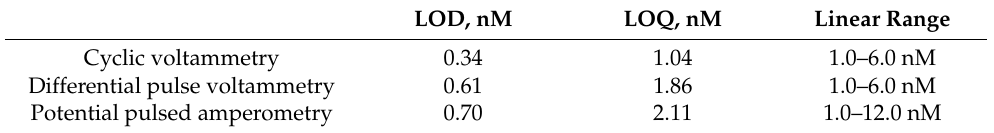
Table 1. Comparison of the LOD and LOQ values obtained by the three electrochemical methods. LOD, nM LOQ,